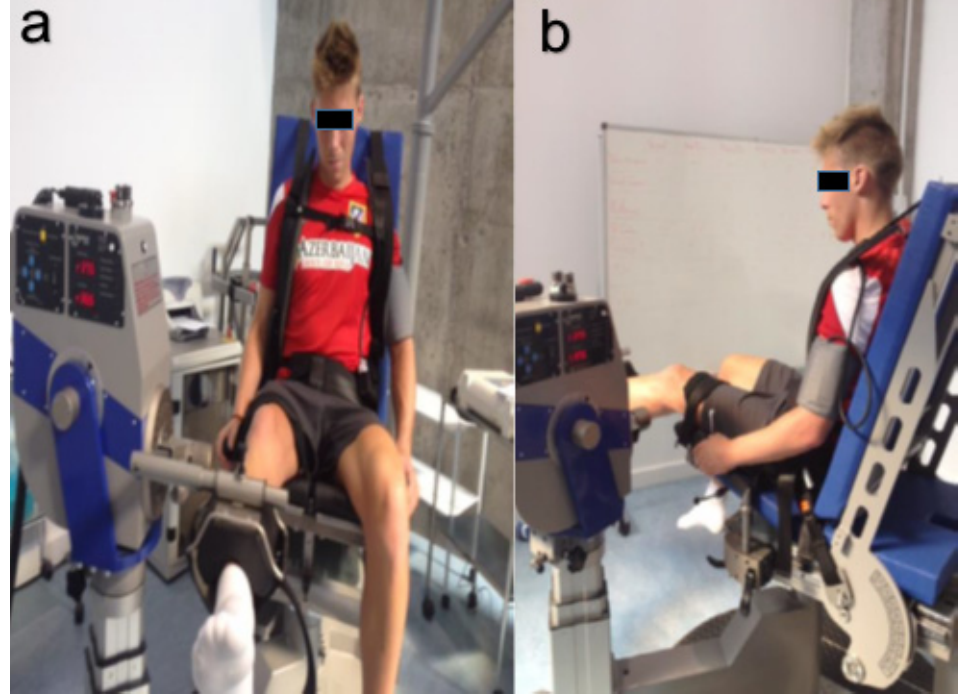
Figure 1. Positioning of a subject before starting the isokinetic testing protocol ( a ) and prior to the beginning of the contraction series with the left lower extremity ( b ).